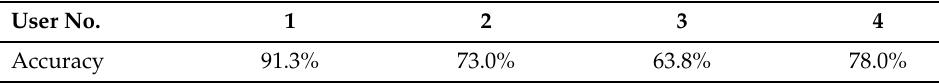
Figure 5. Trend of the relevance of the QOL scale. Table 3. Accuracy of content classification based on QOL scale.